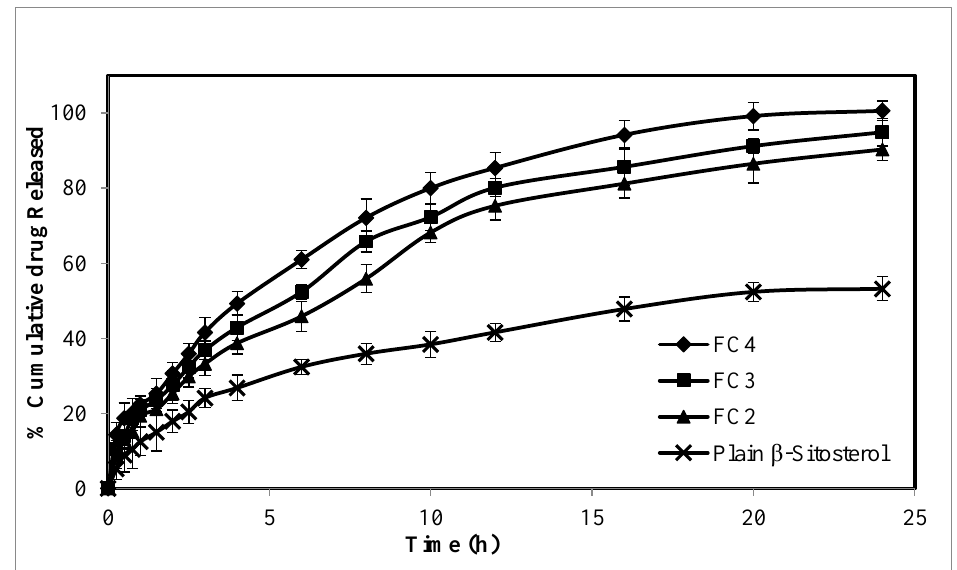
Figure 1. In vitro release study of β - ST from the prepared β - ST - CUBs. Increasing the GMO concentration resulted in decreasing the drug release rate from the cubosomes. An increase in the GMO concentration increases the matrix viscosity, and this will, in turn, retard drug diffusion from the lipid bilayer to the aqueous release medium and eventually slow the drug release rate [30]. In turn, this supports the slowest release results obtained by the FC2 and FC3 cubosomal formulations with the highest % lipids due to the hindered diffusion of the release medium to the center of cubosome and hindered drug diffusion outside the cubosome.